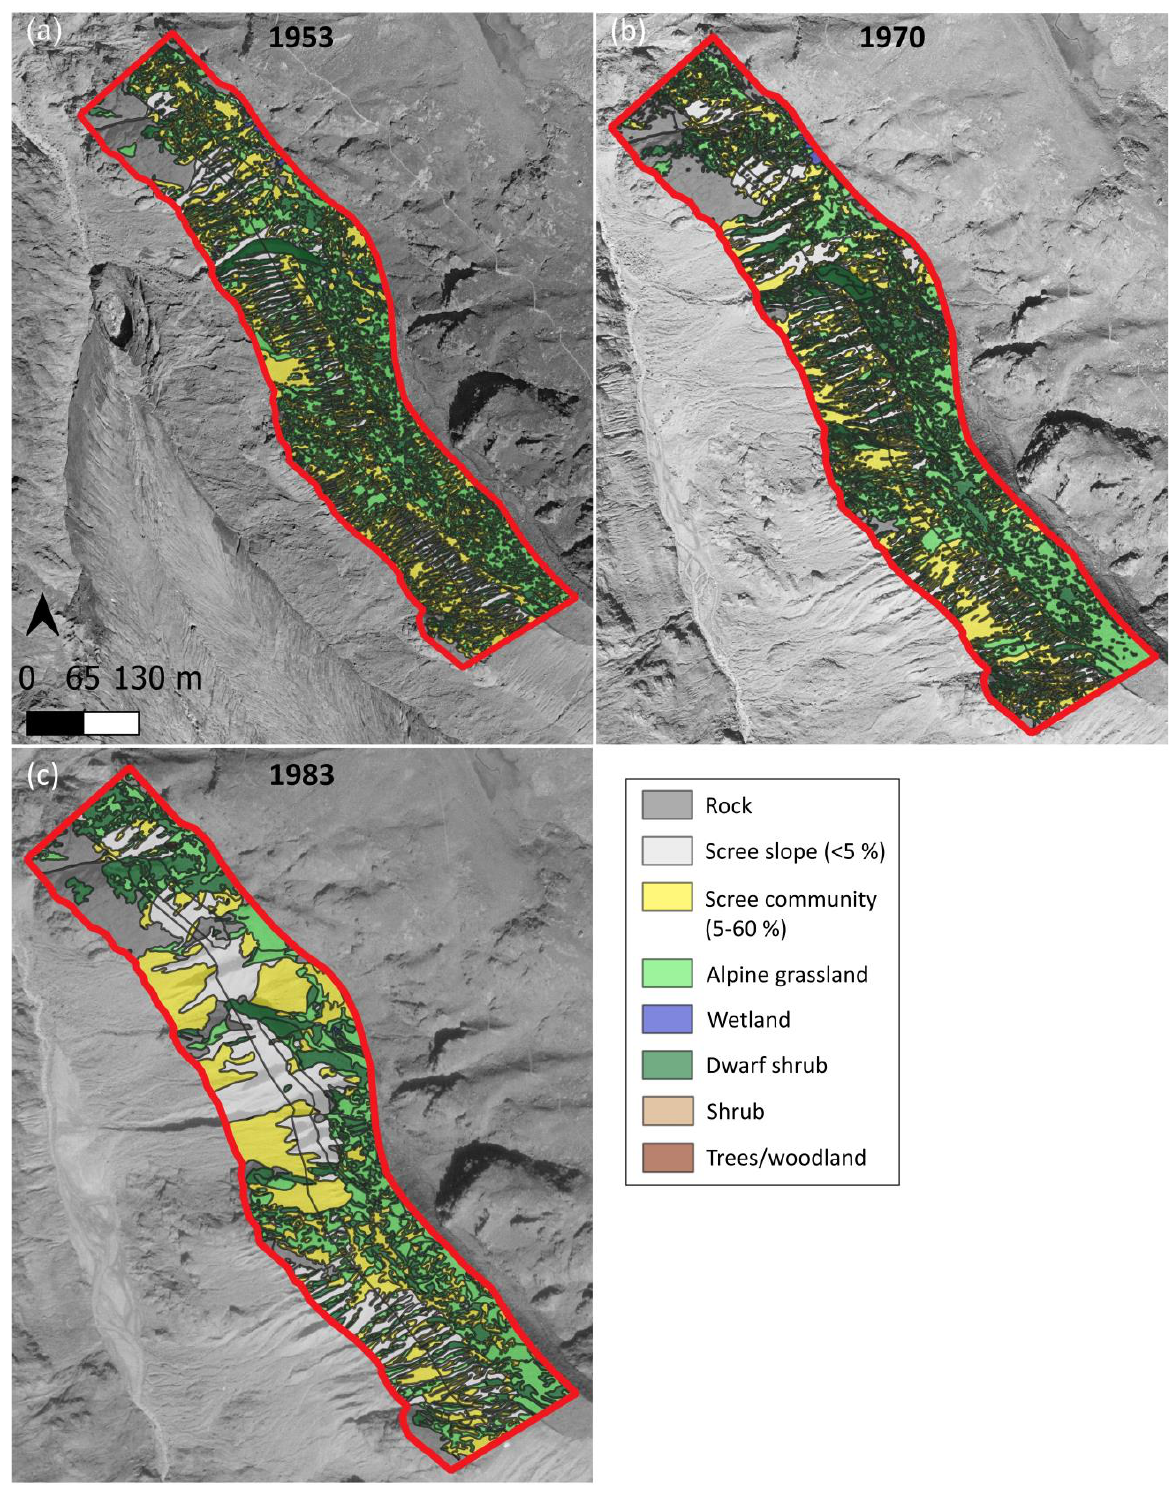
Figure A5. Continued mapping of the different surface types (land-cover mapping) using georeferenced orthophotos based on overlapping area-wide aerial photographs from 1953 to 1983 ( a – c ). The red line indicates area of interest (AoI).